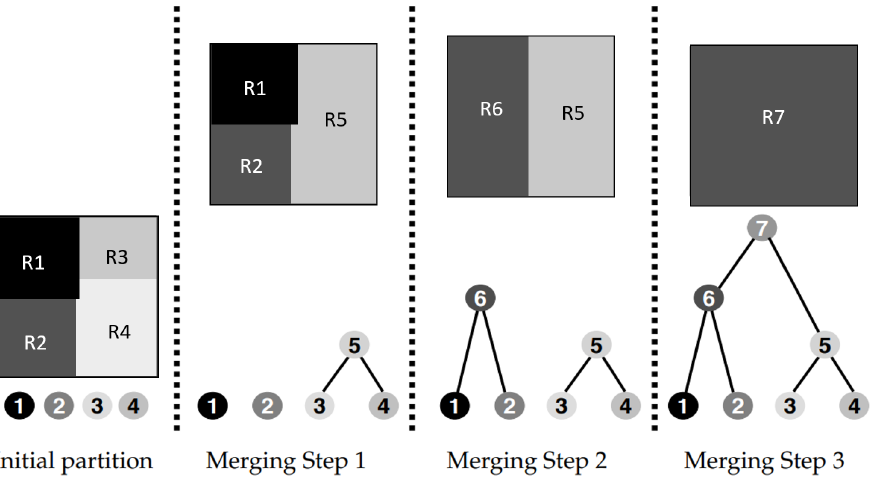
Figure 2. Binary partition trees (BPT) construction using a region merging algorithm as adapted from